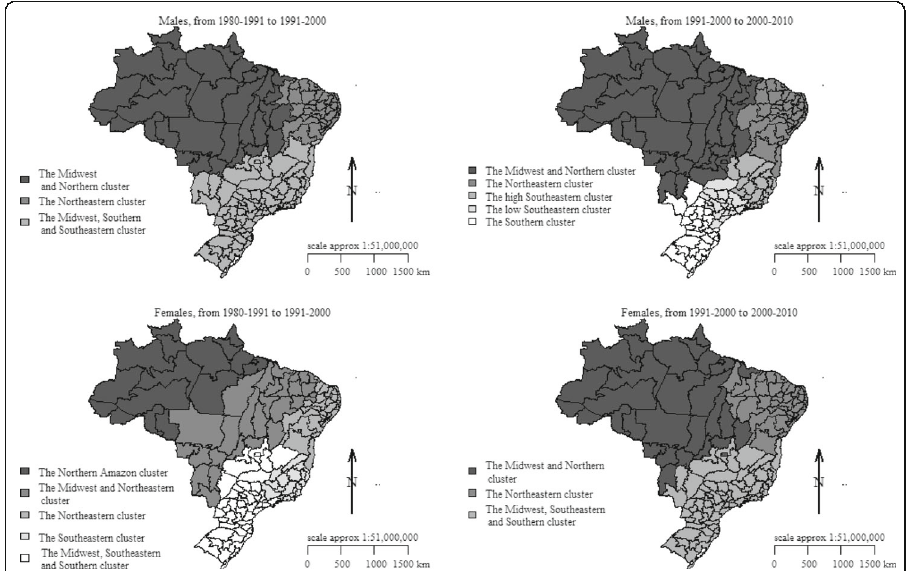
Fig. 6 Spatial cluster of variation in males and female adult probability of death between 1980 and 2010 by mesoregions in Brazil with corrections for underreporting of deaths. Source: IBGE (1980, 1991, and 2000) and DATASUS